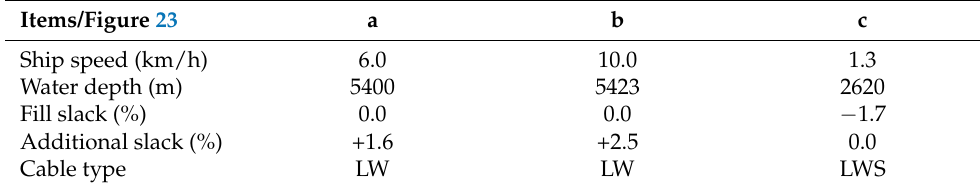
Table 3. Repeater laying conditions for Figure